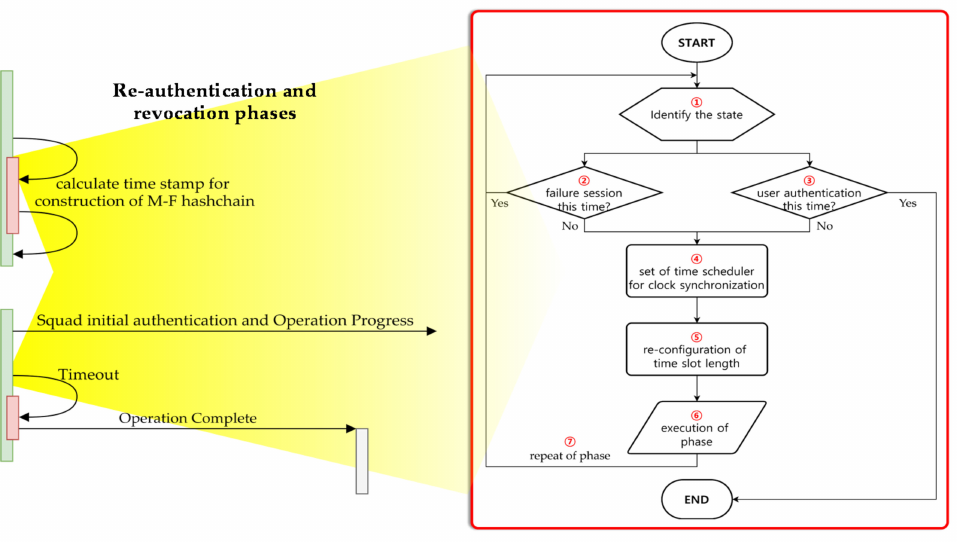
Figure 4. Re-authentication and revocation